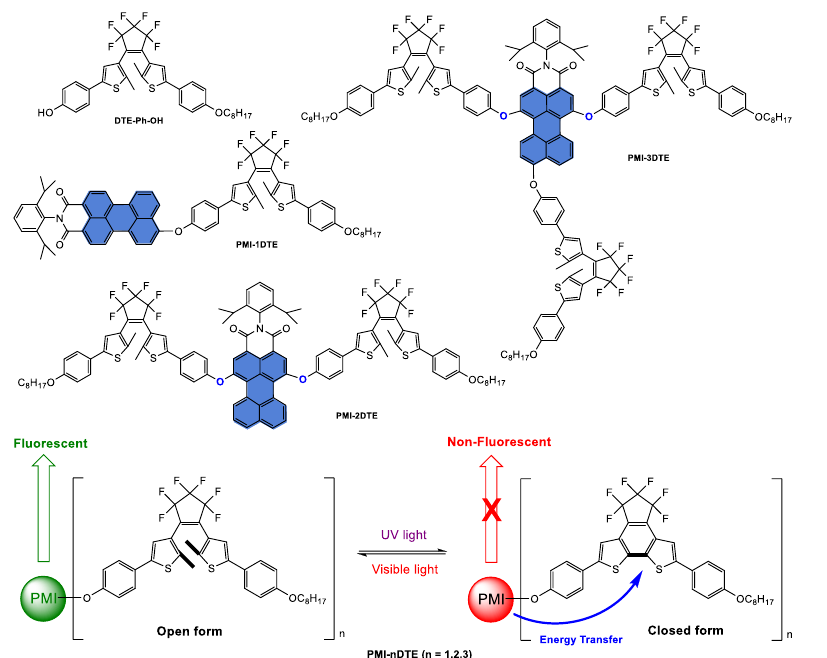
48 of 57 Figure 35. Synthesis of PMI derivatives decorated with a galactose unit and their normalized ab- sorption spectra; illustrations of FHP-nanocluster fabrication, enzyme-triggered disassembly for deep-tumour penetration, near-infrared fluorescence imaging and photodynamic therapy. Adapted and reprinted with permission from reference [154]. Copyright 2020 Wiley-VCH GmbH. Systems composed of one, two or three dithienylethene units (DTE) grafted on the PMI core were designed as a photoswitchable fluorophore for super-resolution imaging [155]. These assemblies were synthesized using a nucleophilic substitution with DTE-Ph- OH in the presence of K 2 CO 3 on 9-bromoPMI 17 and 1,6,9-tribromoPMI 18 , producing PMI-1DTE and PMI-3TDE , respectively (Scheme 14). The triad PMI-2TDE was obtained